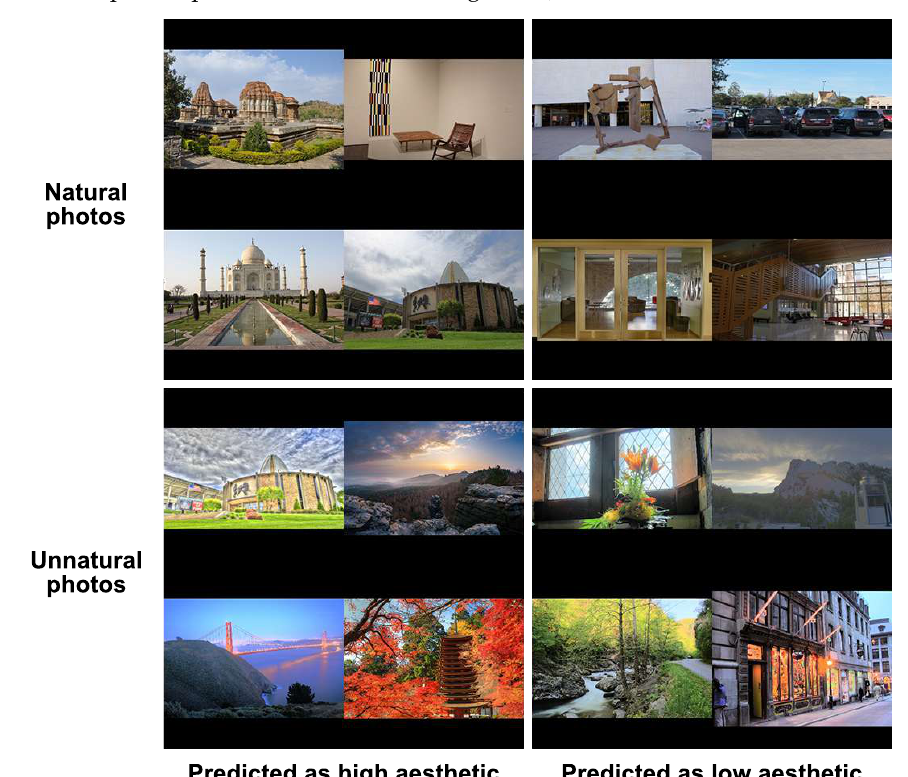
Figure 10. IAA samples of natural and unnatural images.